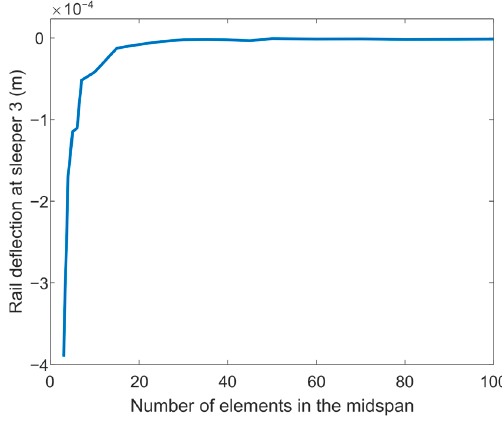
Figure 12. Convergence test of the rail deflection at the sleeper 3.